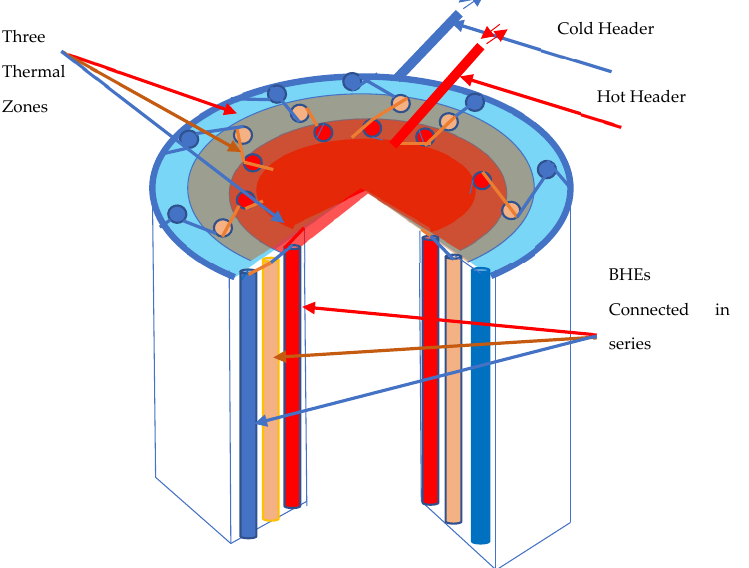
10 of 23 Figure 5. Schematic of an Aquifer Thermal Energy Storage (ATES). The first BTES system established in the world was in Sweden, in 1983, after the en- ergy shortage crisis [80]. As of today, many BTES projects have been completed globally, mostly for storing solar energy in the summer for usage later in the winter [81–85]. BTESs